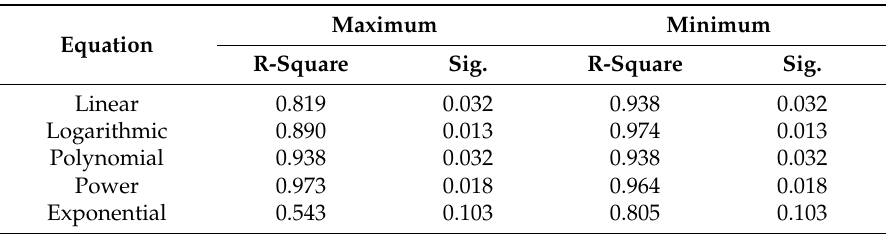
Table 3. Model fitting summary.